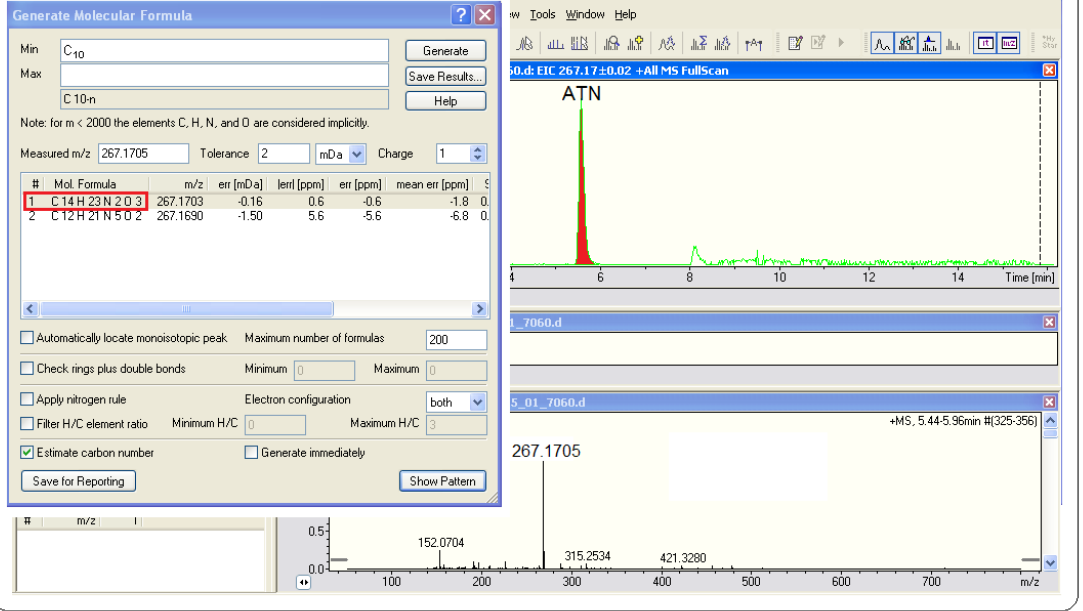
Figure 5. Bruker Daltons Data Analysis software with atenolol as an example.